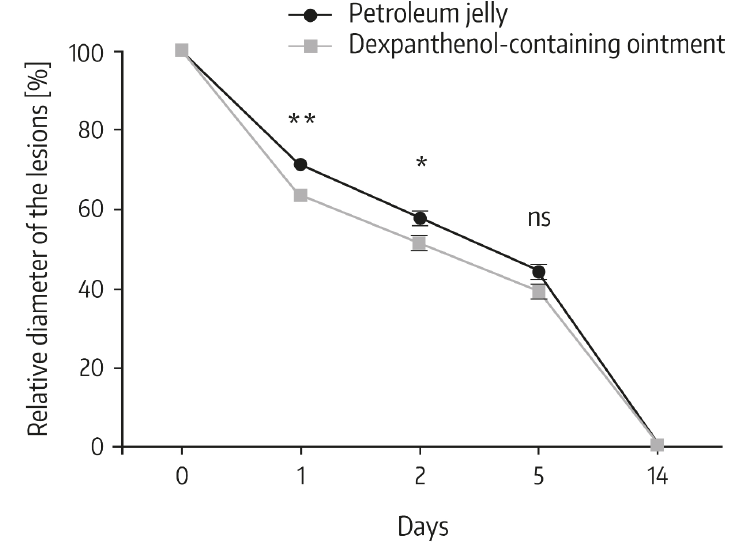
Figure 2. Change of the diameter of the individual lesions between study visits. The diameter of 10 point lesions was determined immediately after laser therapy and mean diameter was set to 100% and used for standardization. Data show mean ± standard deviation with n = 38, * p < 0.05, ** p < 0.01 (Mann – Whitney U test); ns: not significant. From Ref. [2] reprinted with permission of Informa UK Limited, trading as Taylor & Francis Group (www.tandfonline.com).